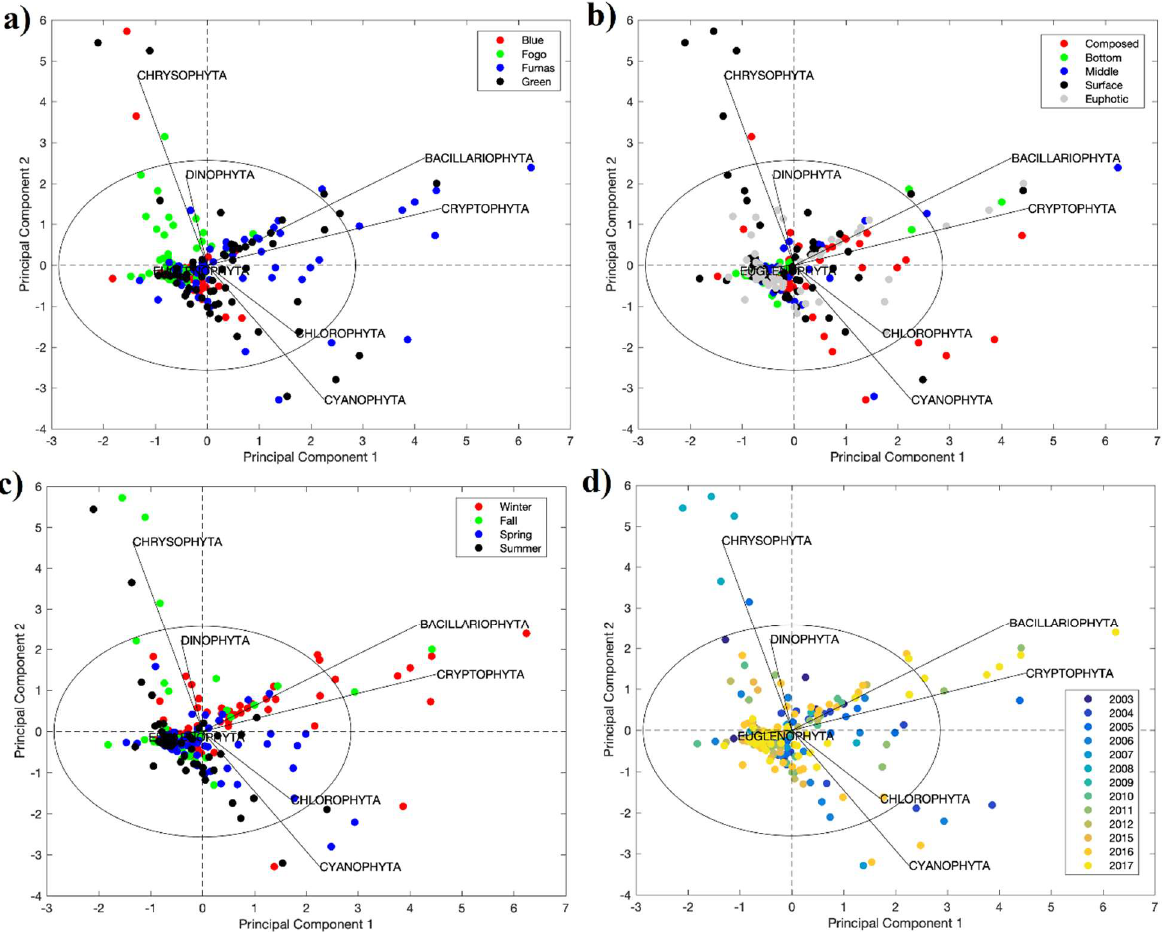
Figure 3. Biplots for the multivariate analysis of biomass (10 −9 mg/L), considering phytoplankton descriptors colored according to ( a ) lakes, ( b ) depths of sampling, ( c ) seasons and ( d ) years from data collection.